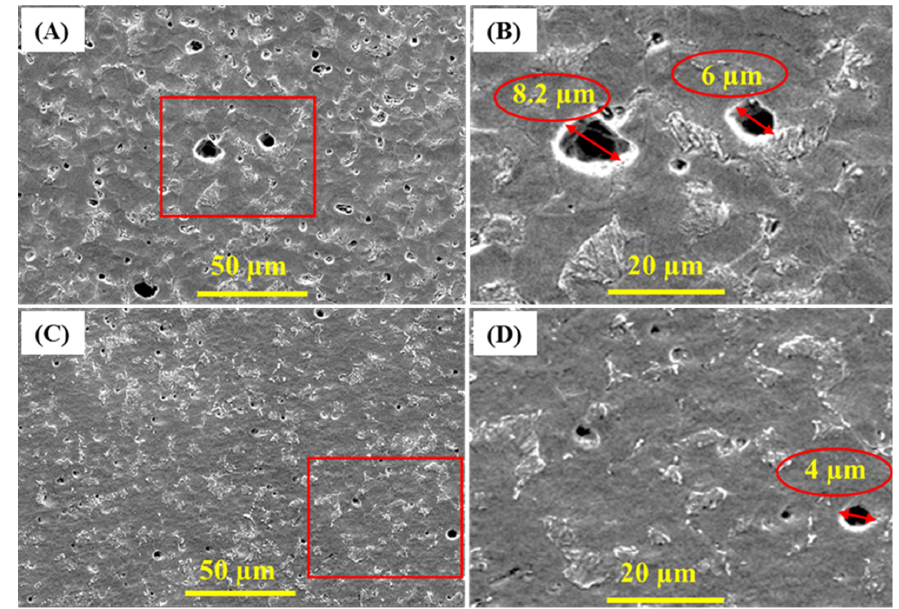
Figure 7. SEM micrograph of corrosion pits after removing the corrosion products from SS400 coupons incubated in SRB alone ( A , B ) and in presence of CS / LS nanospheres ( C , D ) after 35 days of